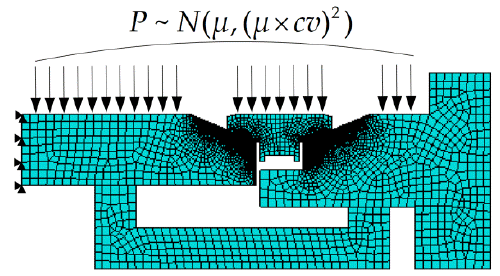
Figure 4. The R-FE model of the VX gasket.